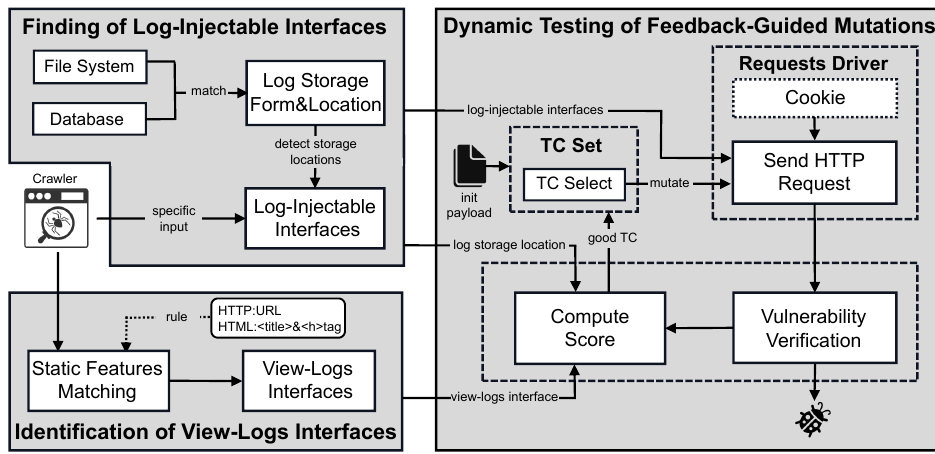
Figure 1. The architecture of LogInjector. (TC in the figure represents the test